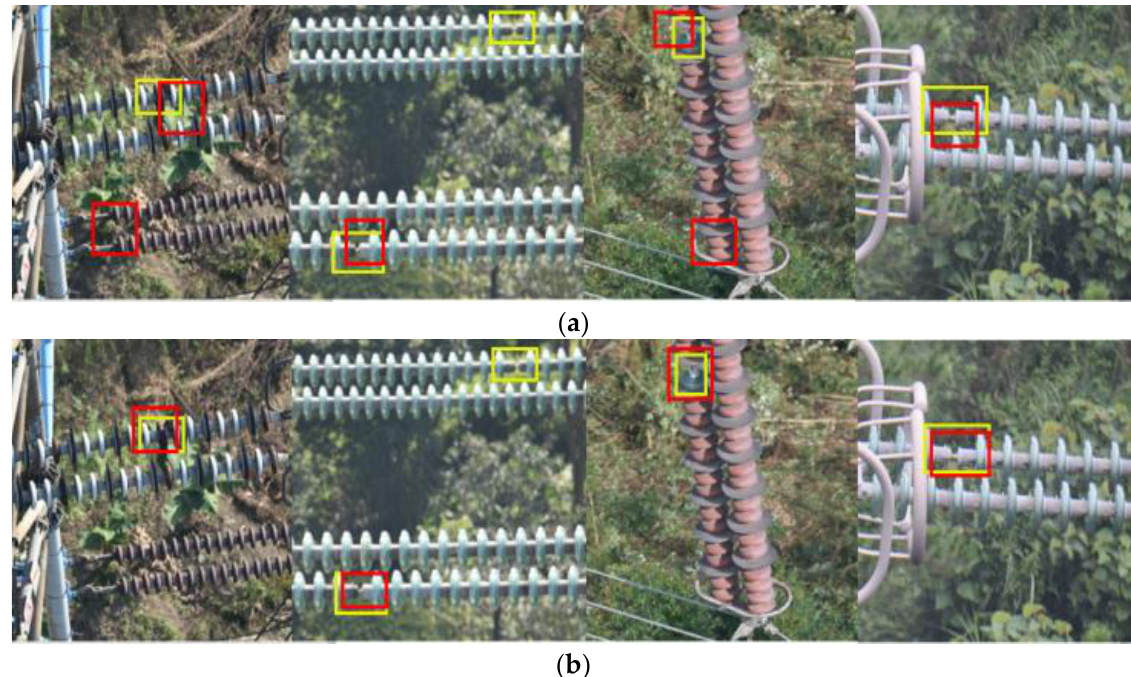
Table 5. Detection results using different techniques in our network. FPN RA